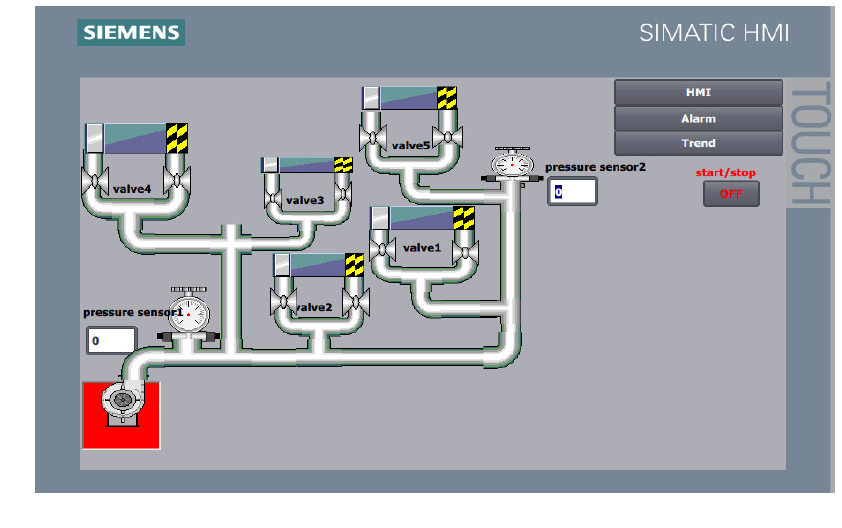
Fig. 11. HMI in touch panel .